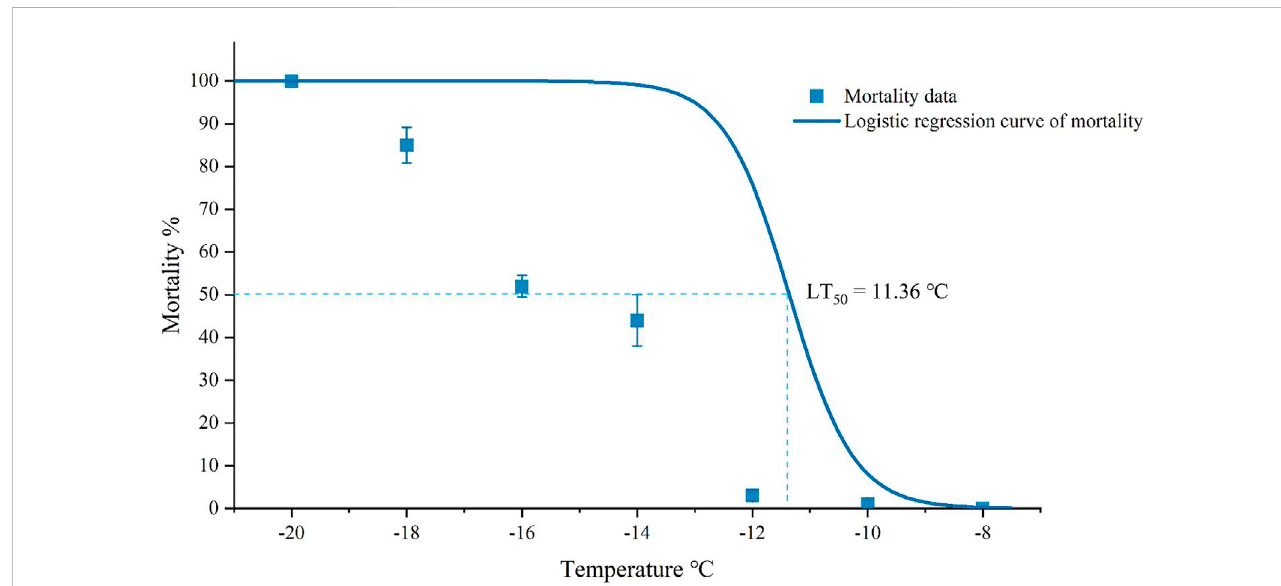
FIGURE 3 Mortality of Megabruchidius dorsalis adults after acute (1 hour) low-temperature exposure. The data were Mean ± SE, and lower lethal temperature and LT 50 were estimated using logistic regression ( p <